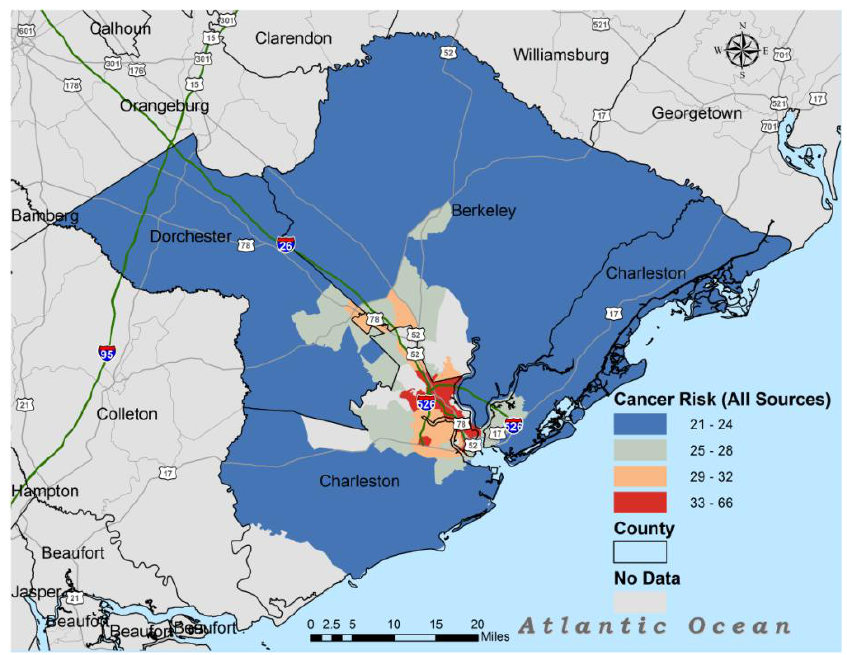
Figure 1. Lifetime cancer risk from all sources of air toxics for metropolitan Charleston.